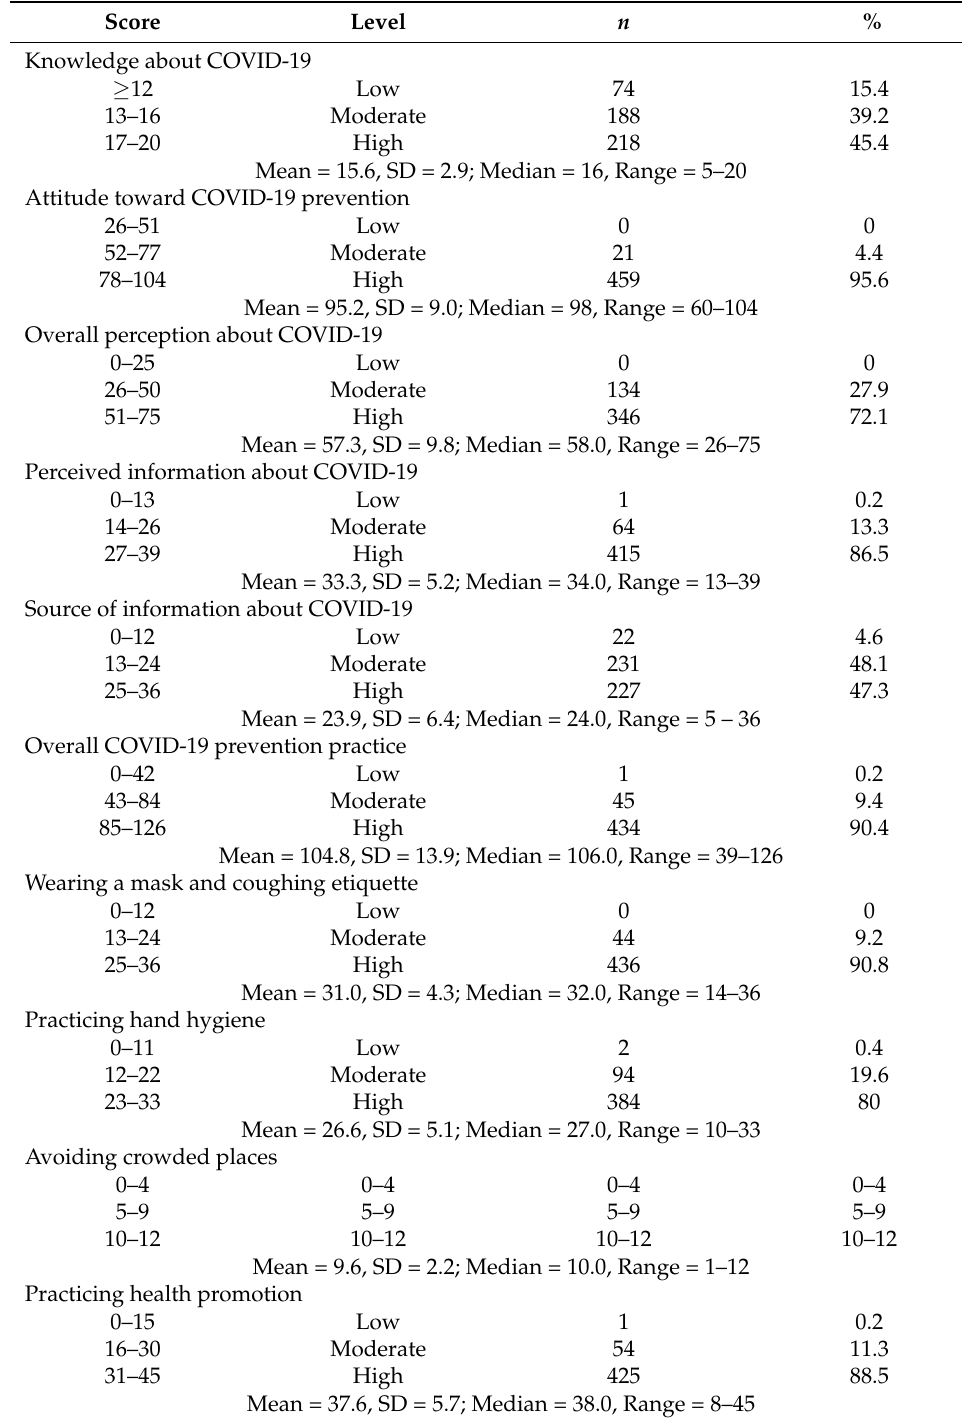
Table 2. Level of COVID-19 knowledge, attitude, perception, and prevention practices among participants ( n =